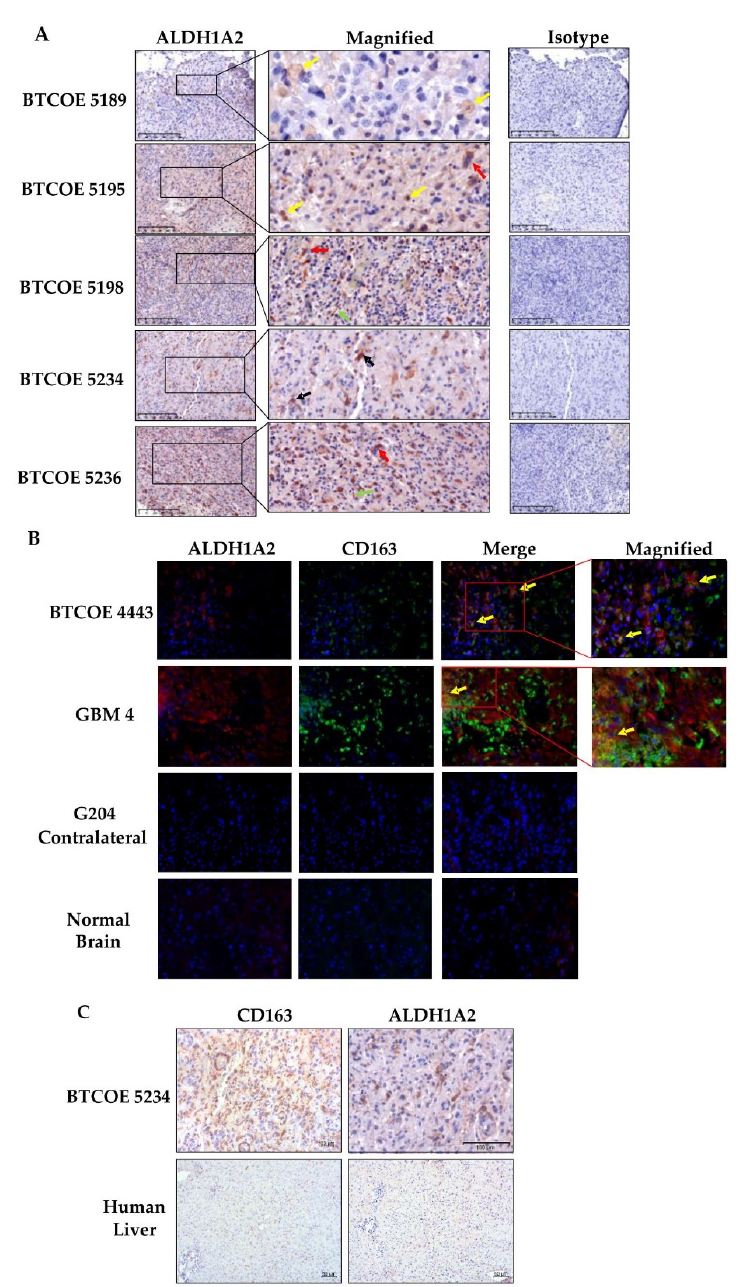
Figure 3. Expression of ALDH1A2 in the GBM tumor microenvironment. ( A ) Immunohistochemical staining of tumors used for single-cell sequencing (Figure 6 below) shows a relatively high number of ALDH1A2 + cells. These cells are represented by macrophages (yellow arrows), multinucleated tumor cells (red arrows), non-activated microglia (green arrows), and reactive astrocytes (black arrows). These images are representative of over 10 tumors tested. ( B ) Immunofluorescent staining for ALDH1A2 and the M2 macrophage marker CD163. Some M2 macrophages are also ALDH1A2 positive (yellow arrows). Please note that neither CD163 nor ALDH1A2 are abundant in normal brain. These images are representative of over 10 tumors tested. Scale bars are 50 µ m. ( C ) ALDH1A2 is expressed in GBM-associated macrophages but not in normal human liver, which is enriched in CD163 +